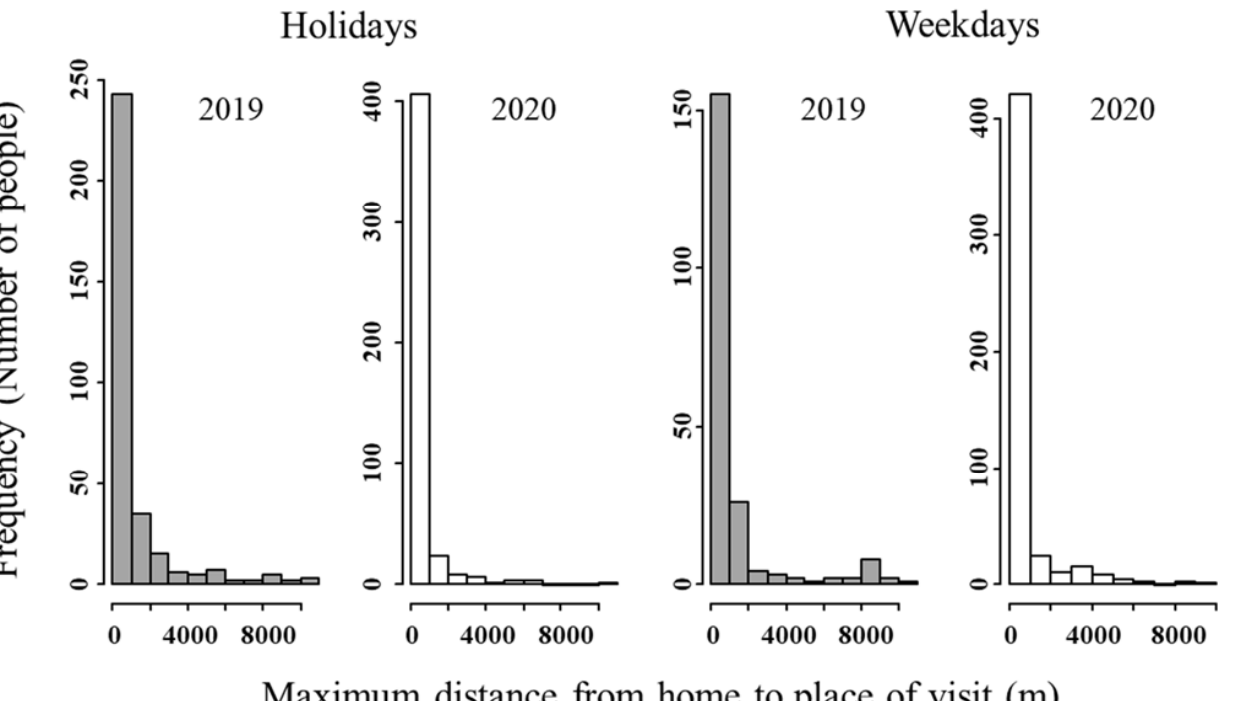
Figure 5. Maximum distance from home to place of visit for a day. Note that the vertical scale differs between 2019 and 2020.